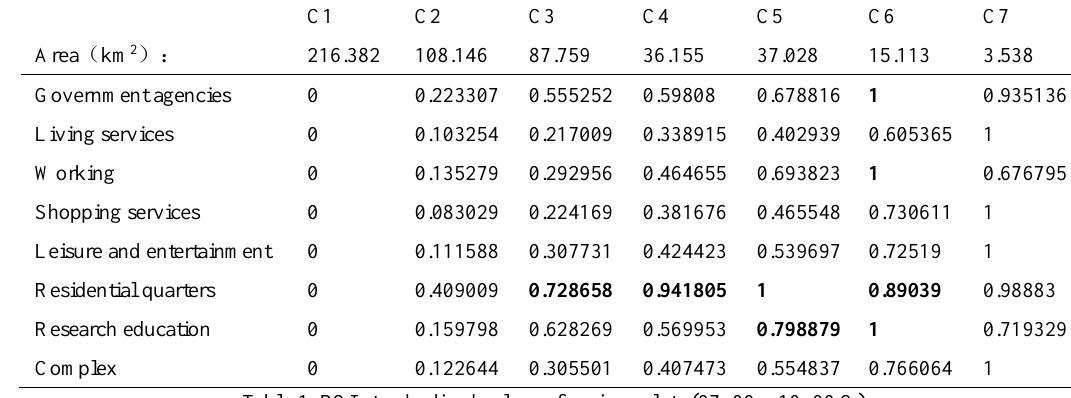
Table 1. POI standardized values of various plots (07: 00 ~ 10: 00 O) C1 C2